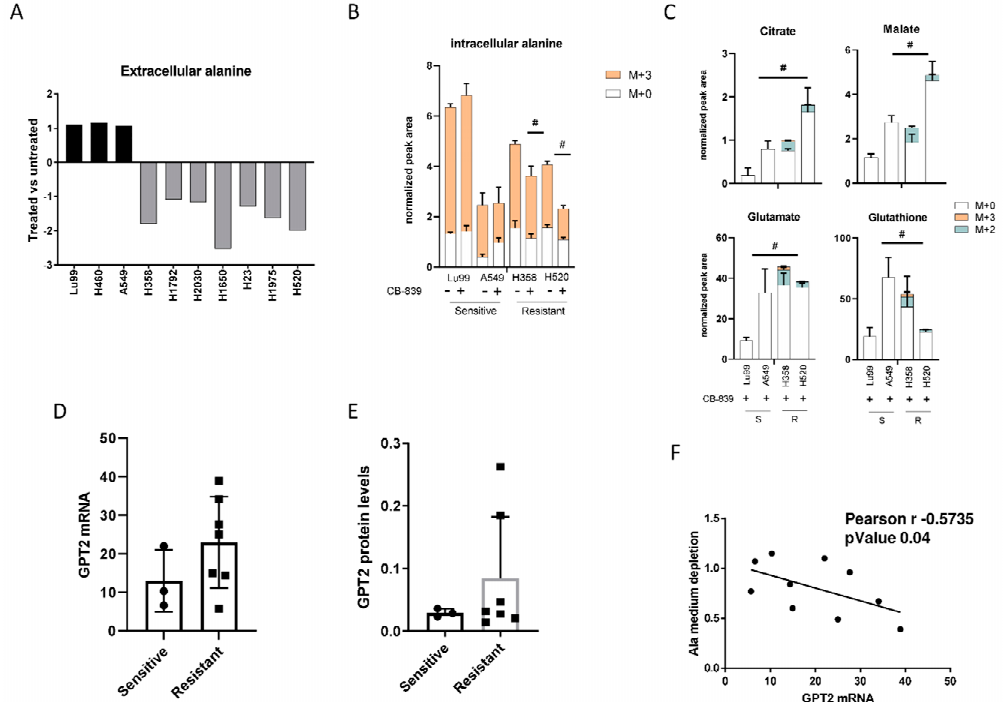
Figure 3. ( A ) Changes in extracellular alanine levels in the panel of ten NSCLC cell lines, CB-839-treated vs. untreated, cells (500 nM, 24 h treatment). ( B ) Unlabeled and 13C 3 -labelled alanine incorporation (M + 0, M + 3) in two sensitive (LU99, A549) and two resistant (H358, H520) cells, either untreated or CB-839 treated (500 nM, 24 h treatment). ( C ) The 13C 3 -alanine-derived carbon labelling (M + 2, M + 3, normalized peak area) of TCA cycle intermediates and citrate, malate, glutamate and glutathione derived metabolites in CB-839 treated sensitive and resistant cells. ( D ) GPT2 mRNA expression as RNA-seq, retrieved from the CCLE in the sensitive and resistant cells. ( E ) Western blot analyses of GPT2 expression in the NSCLC cell line panel. Ran was used as loading control. ( F ) Pearson correlation between alanine uptake from each cell line’s medium and GPT2 mRNA expression, retrieved from the CCLE. The average of three independent experiments is reported. Statistical significance # p < 0.05 refer to significant di ff erences (one-way ANOVA and Tukey Kramer test) of M + 2 and M + 3 in the resistant vs. sensitive cells.